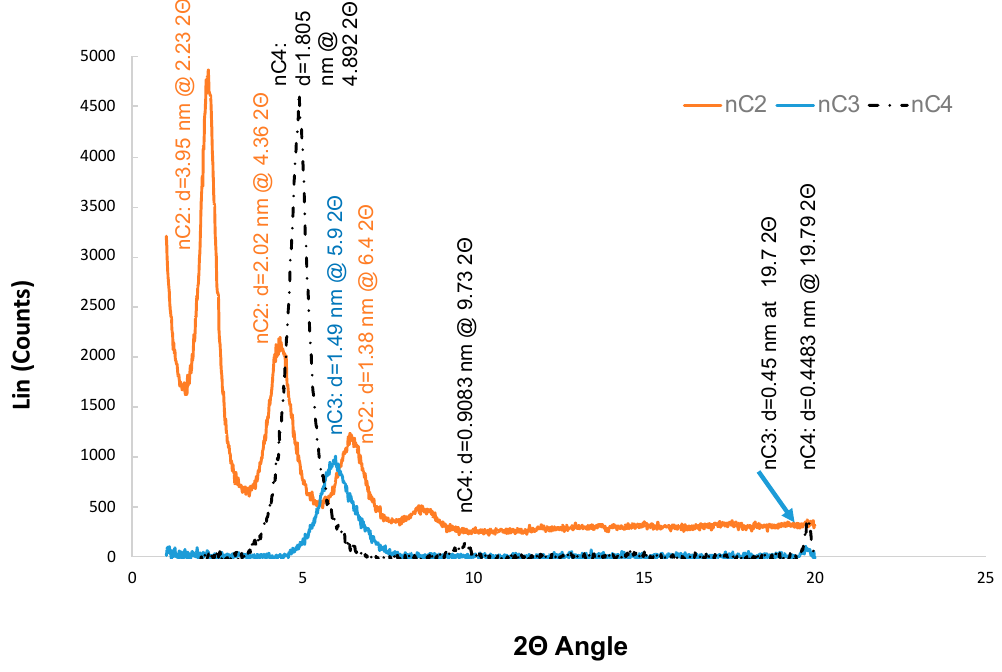
Figure 2. Comparison of the X ‐ Ray diffraction pattern of the organomodified montmorillonite (MMT) dispersion (nC2), inorganic MMT dispersion (nC3) [19], and organomodified MMT powder (nC4).